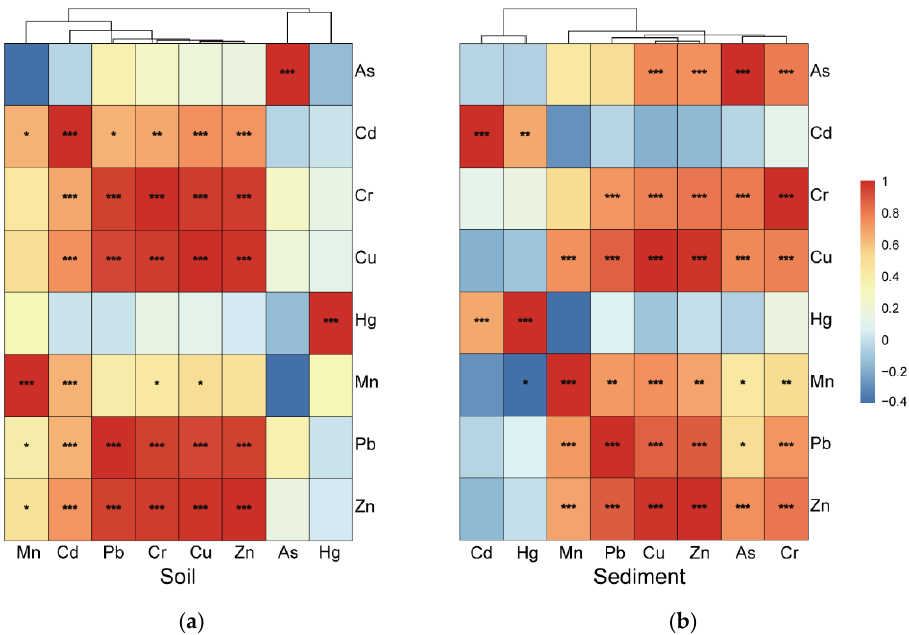
Figure 8. Correlations of metals in the surface soil ( a ) and sediment ( b ) samples. The colors red and blue represent positive and negative correlations, respectively. * Significant correction at the level of p < 0.05; ** Significant correction at the level of p < 0.01; *** Significant correction at the level of p < 0.001.